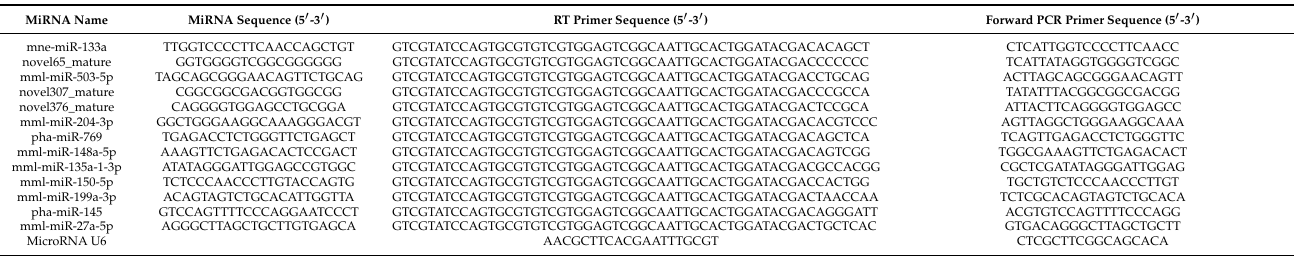
Table 1. Primers used to confirm miRNA expression with